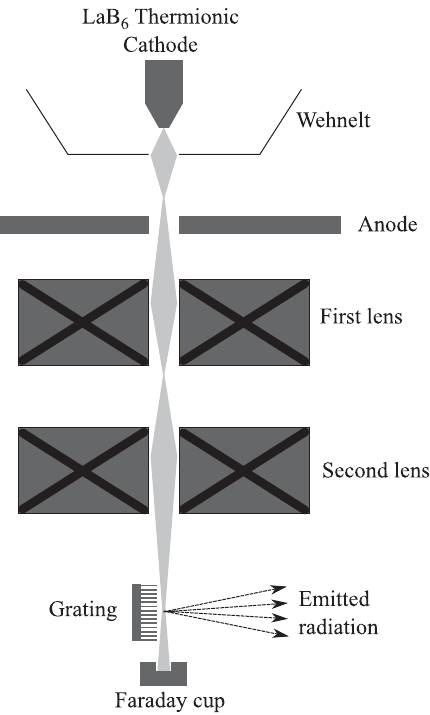
FIG. 2. The electron beam originates at a LaB 6 thermionic cathode. The current is controlled by heater current and wehnelt bias voltage. Beam energies range 26–38 kV, beam currents 0.3– 17 mA. The beam is focused by magnetic lenses and directed perpendicular to the direction of travel by steering coils (not